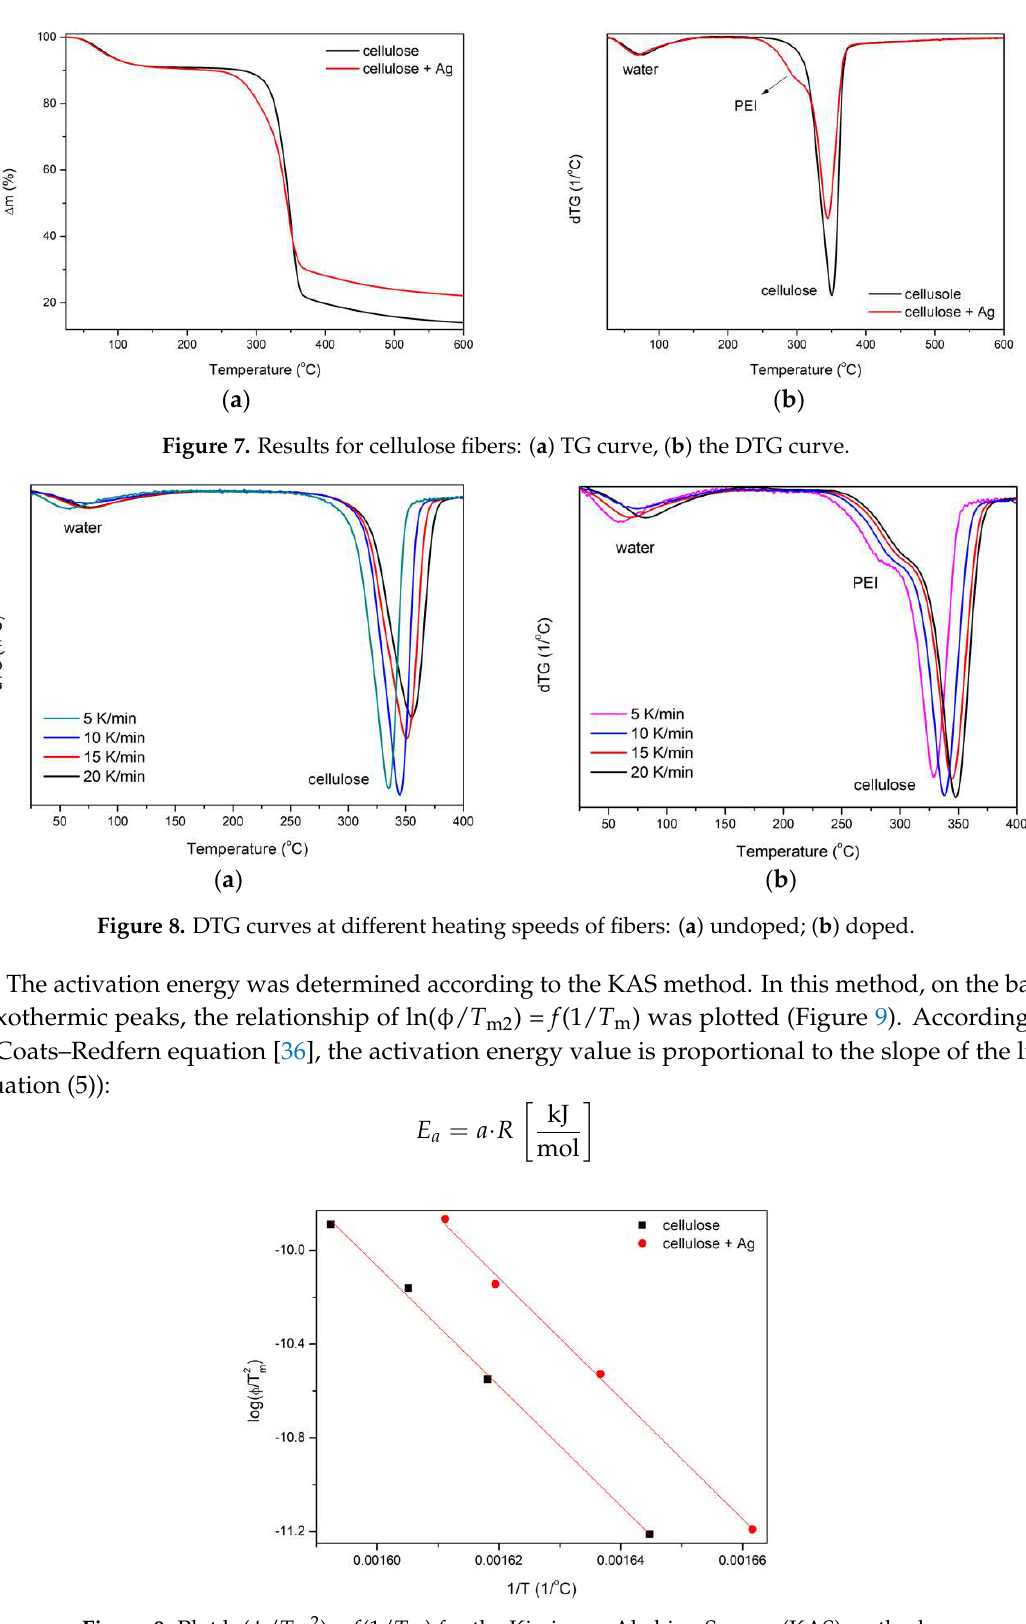
( b ) Figure 6. Heat release rate (HRR) of cellulose fibers: (a) time dependence, (b) temperature. Table 2. Flammability parameters of cellulose fibers. THR, total heat release. Fibers